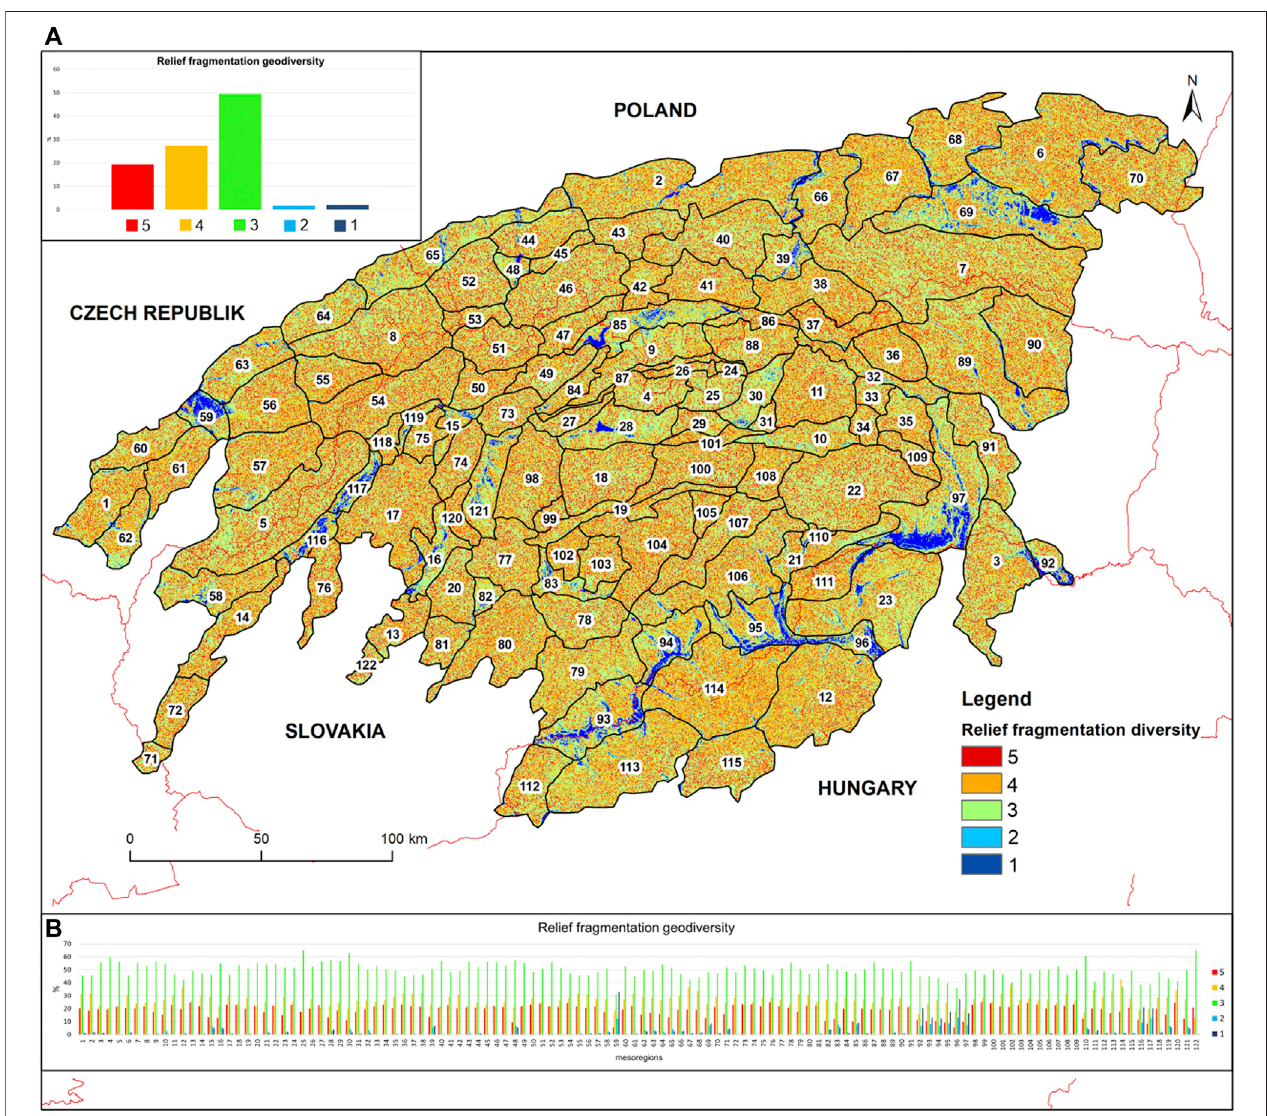
FIGURE 5 | Relief geodiversity map. 5: summit/spur; 4: ridge/valley/shoulder; 3: slope/hollow; 2: footslope; 1: fl at/depression. For numbers of mesoregions, see Figure 2 . Source: own research.